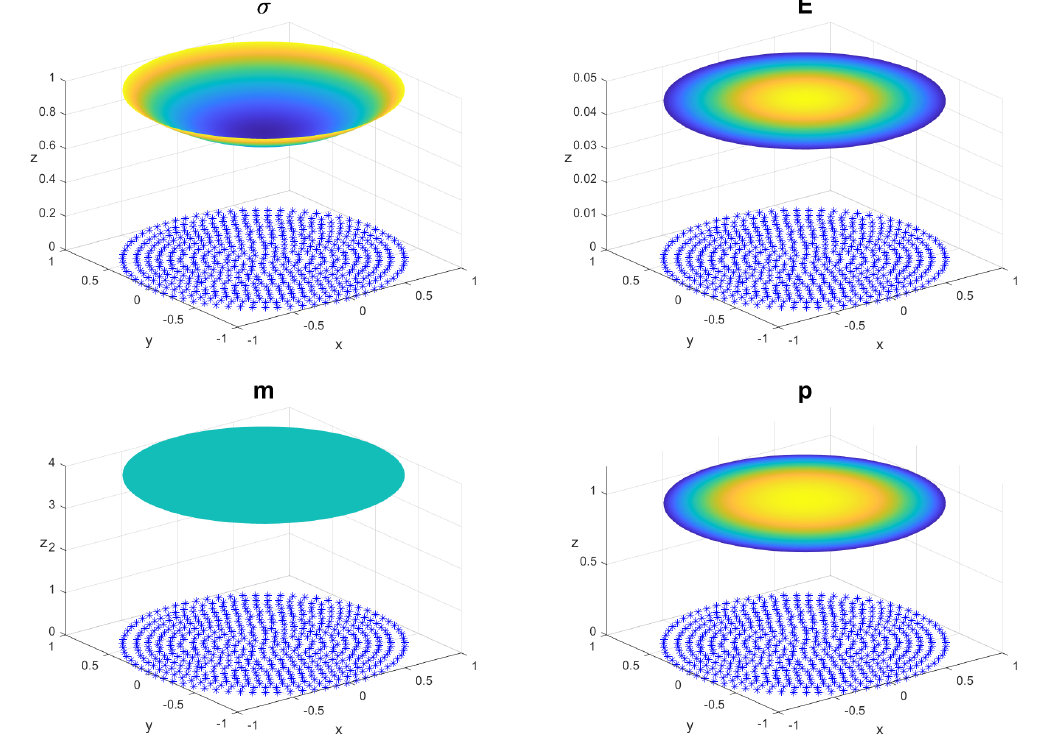
Figure 8. Graphs of the functions: σ , E , m and p for t = 2 s.